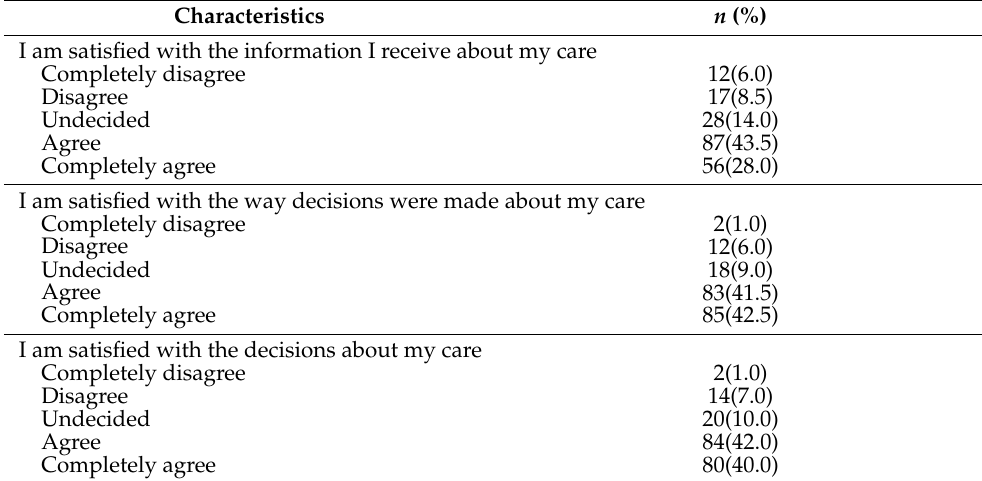
Table 3. Patient satisfaction with the decision-making process ( n = 200).